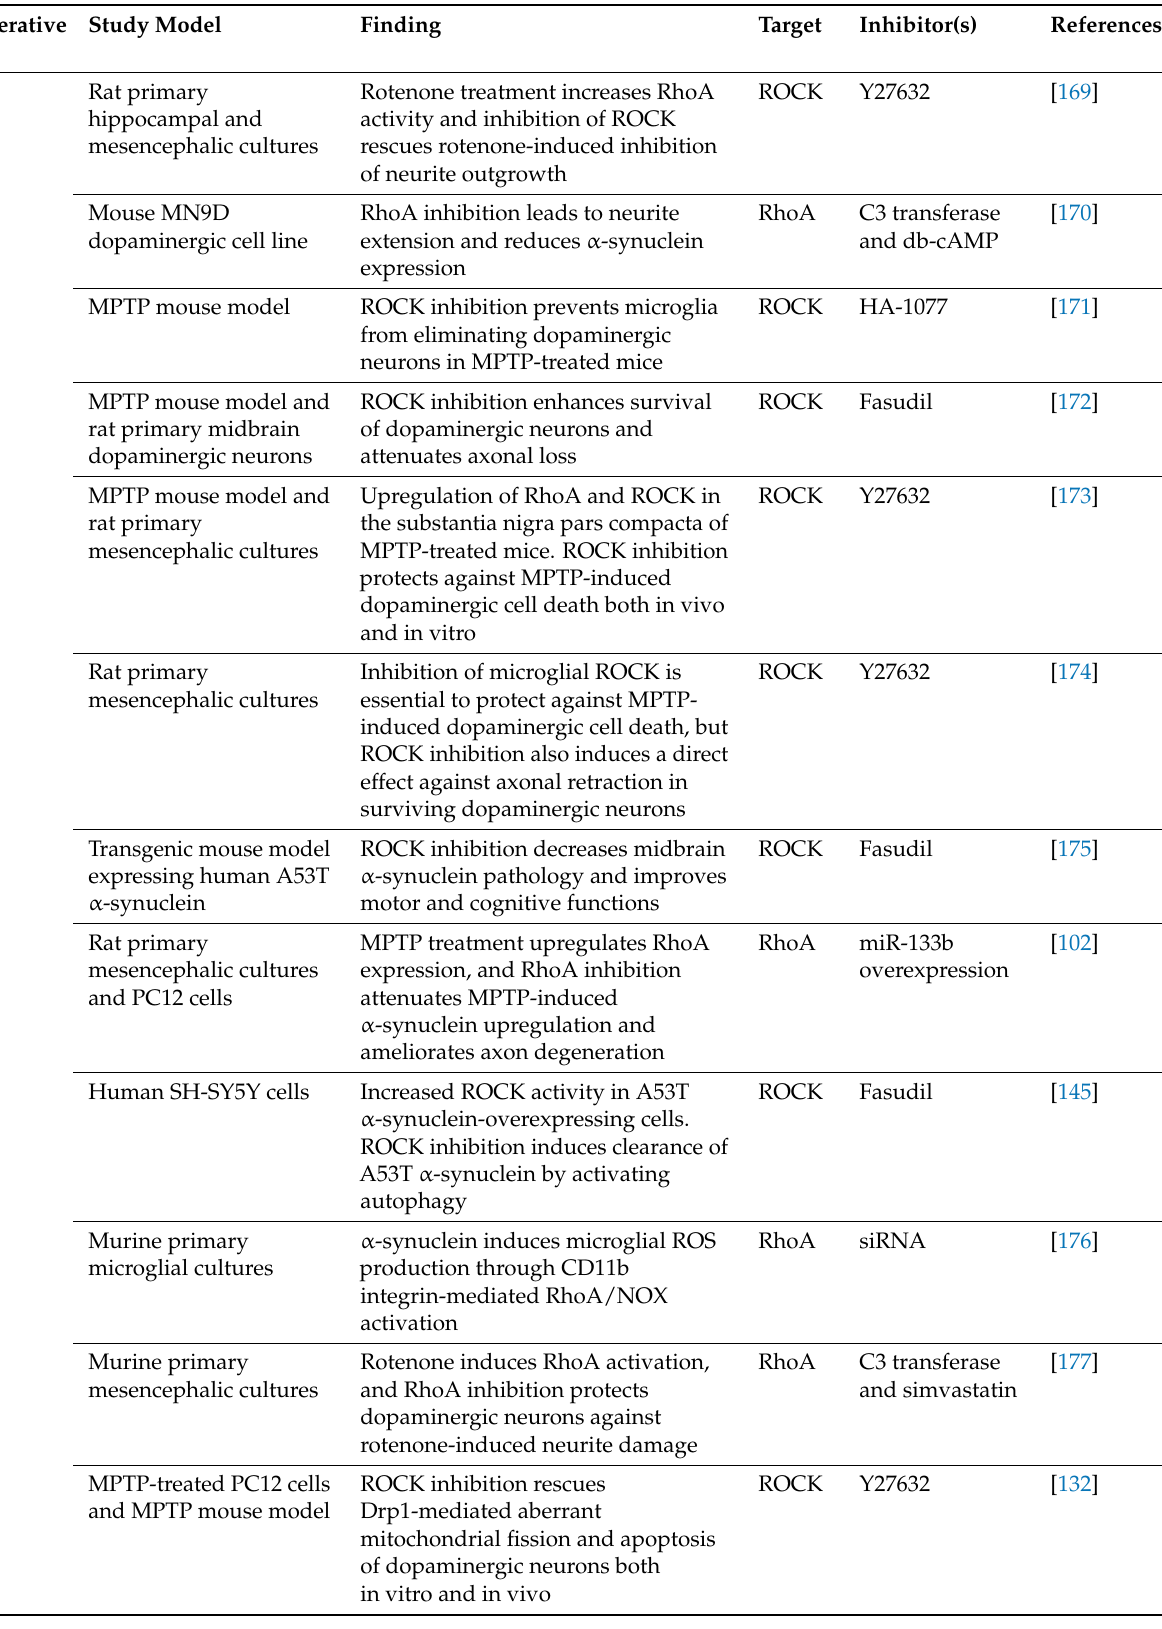
Table 3. Studies linking RhoA signaling to Parkinson’s disease, Alzheimer’s disease, Huntington’s disease, and amyotrophic lateral